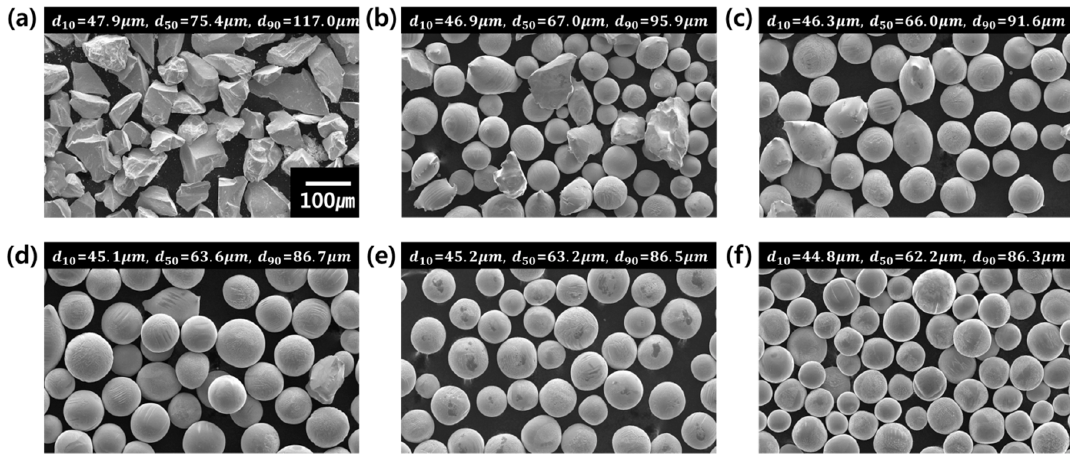
Figure 2. Morphology of the powders ( a ) after ball-milling and sieving, and ( b – f ) after spheroidizing by inductively coupled thermal plasma, with plasma powers of ( b ) 3 kW, ( c ) 4 kW, ( d ) 5 kW, ( e ) 6 kW, and ( f ) 7 kW.